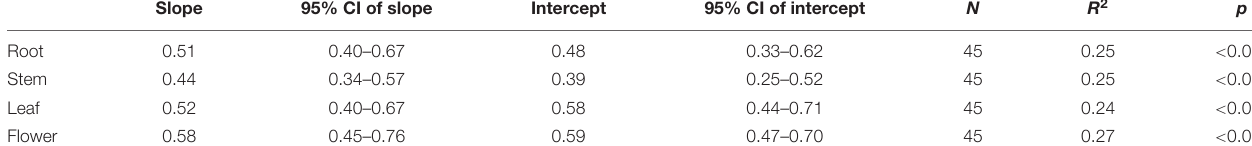
TABLE 3 | Parameters for the stoichiometric relationships between N and P in plant organs.